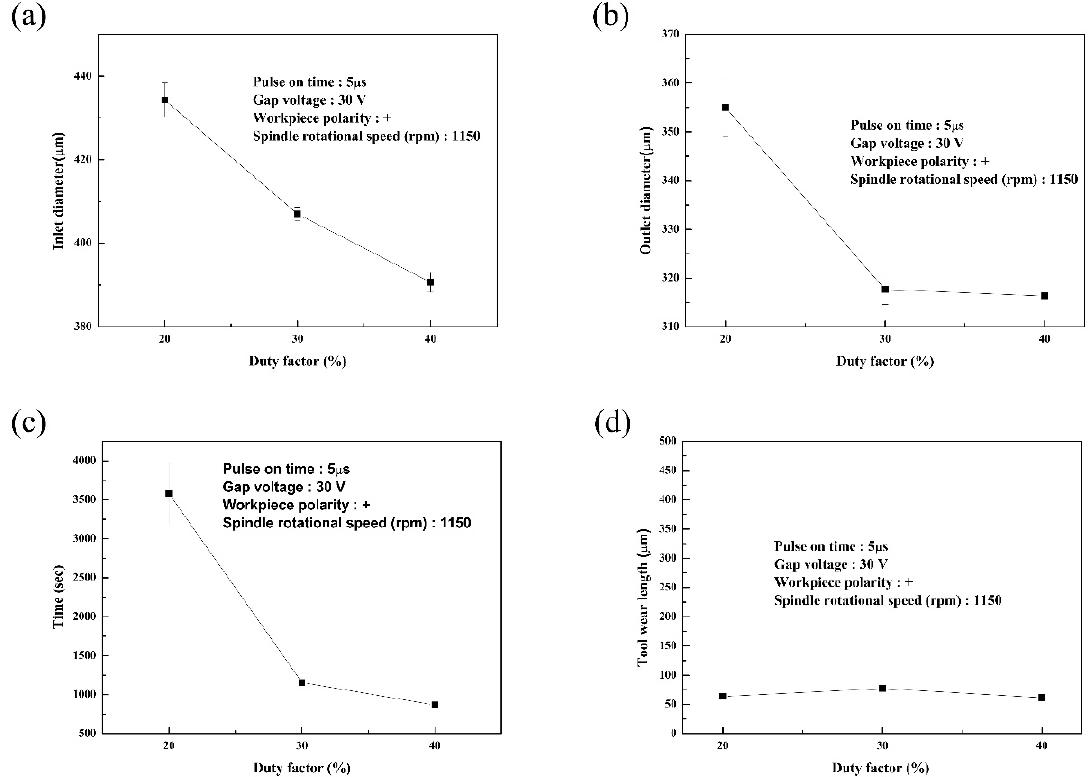
Figure 8. The relationship between duty factor and ( a ) inlet diameter, ( b ) outlet diameter, and ( c ) machining time. ( d ) Length of electrode wear.